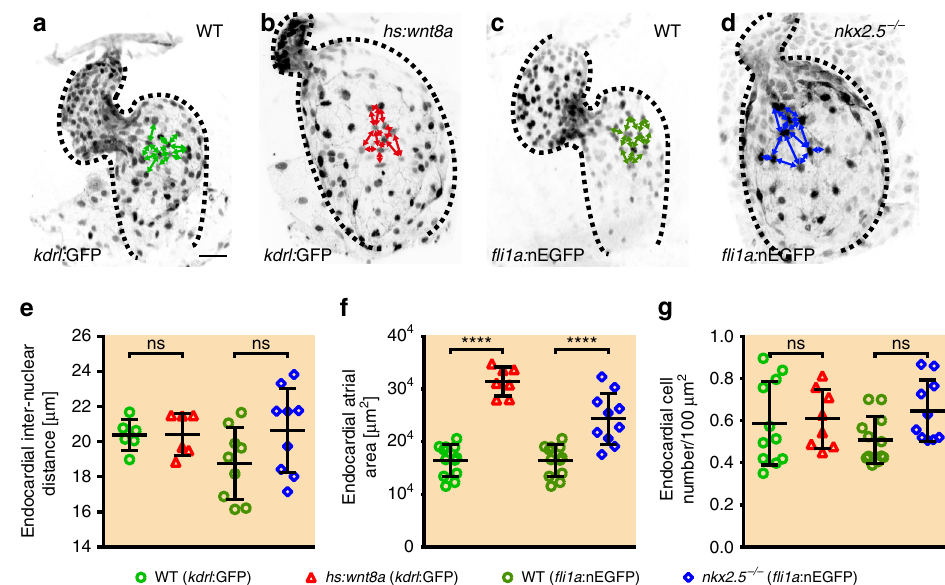
Fig. 3 Endocardial cell sizes are not altered upon atrial chamber expansion. a – d Reconstructions of confocal z-stacks of representative hearts at 52 hpf of ( a ) WT, ( b ) upon Wnt8a overexpression, ( c ) WT, or ( d ) in nkx2 . 5 vu179 mutants. Endocardial GFP expression of Tg(kdrl:EGFP) s843 or Tg( fl i1a:nEGFP) y7 is inverted in black/white. Endocardial inter-nuclear distances are indicated by arrows and a dotted line indicates the outline of the endocardium. Scale bars, 30 µ m. e Quanti fi cations of endocardial inter-nuclear distances reveal no signi fi cant differences between WT ( kdrl :GFP n = 6 hearts, fl i1a :nEGFP n = 9 hearts), upon Wnt8a overexpression ( n = 6 hearts), or in nkx2 . 5 vu179 mutants ( n = 9 hearts). Each dot represents one heart with an average of at least 20 length measurements within the endocardial atrium. f Quanti fi cations of the atrial endocardial surface area reveals a signi fi cant increase upon Wnt8a overexpression ( n = 7 hearts) or loss of Nkx2.5 ( n = 10 hearts) compared to WT hearts ( kdrl :GFP n = 12 hearts, fl i1a :nEGFP n = 12 hearts). g Quanti fi cations of the ratio of endocardial cell numbers relative to total atrial chamber area indicates no signi fi cant differences between WT ( kdrl :GFP n = 11 hearts, fl i1a :nEGFP n = 12 hearts), upon Wnt8a overexpression ( n = 8 hearts), or in nkx2 . 5 vu179 mutants ( n = 10 hearts). e – g Mean values ± SD are shown. One-way ANOVA was used to compare each condition with its WT control ( ns : not signi fi cant, **** p <